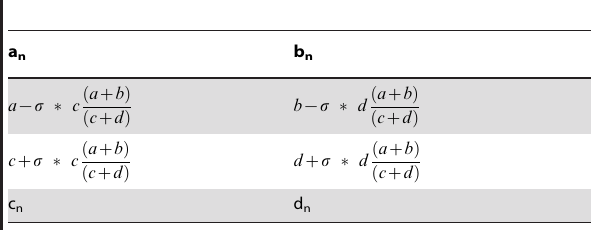
Table 4. Adjusted observed values when phenocopies are reclassified as